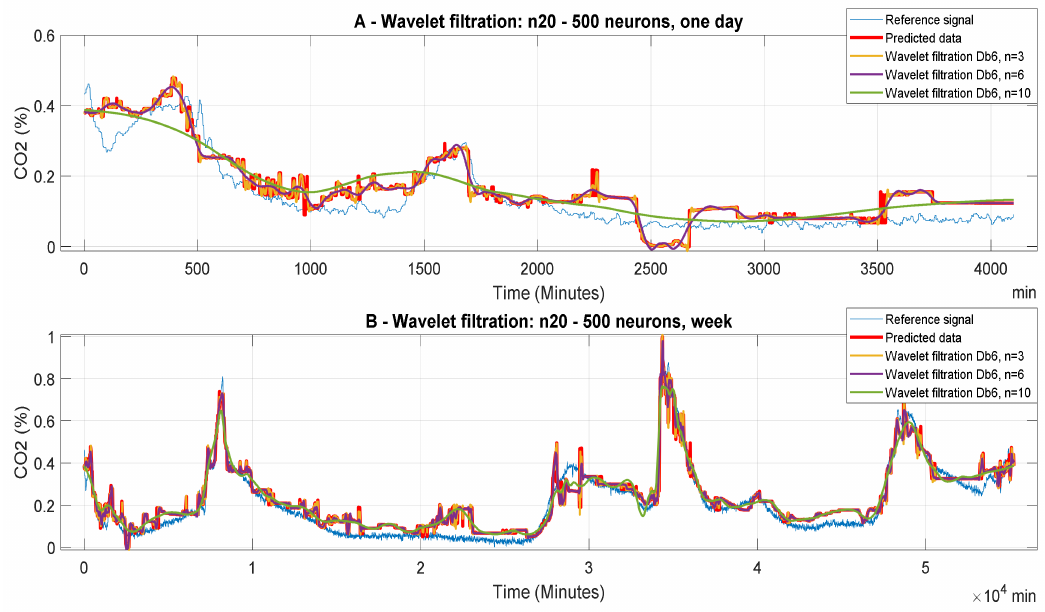
Figure 7. CO 2 concentration for di ff erent time periods using Model 12 (n20 to 500 neurons). Wavelet-based filtration is performed for Db6 with level of decomposition, n = 3, 6, and